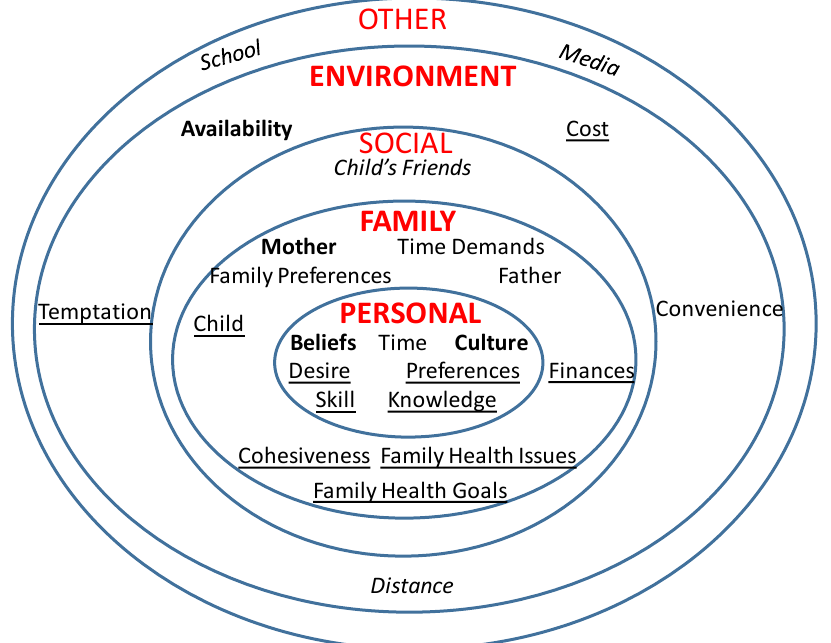
Figure 1. Mother’s thematic network. Legend: Majority of mothers mentioned– bold font;